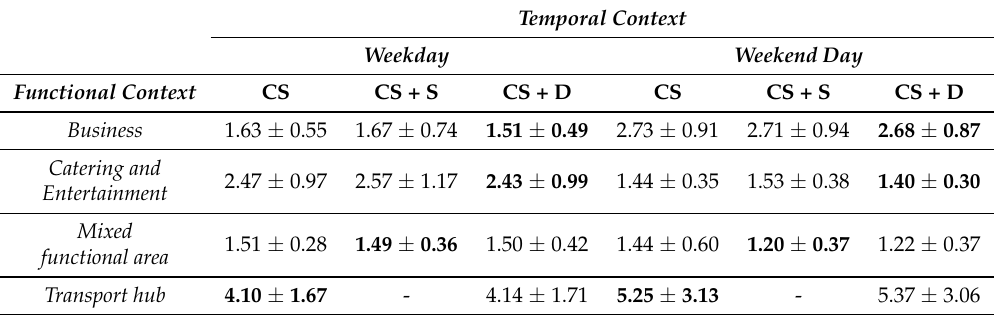
Table 6. Comparison of the data models for different functional contexts, in terms of MAE (avg ±